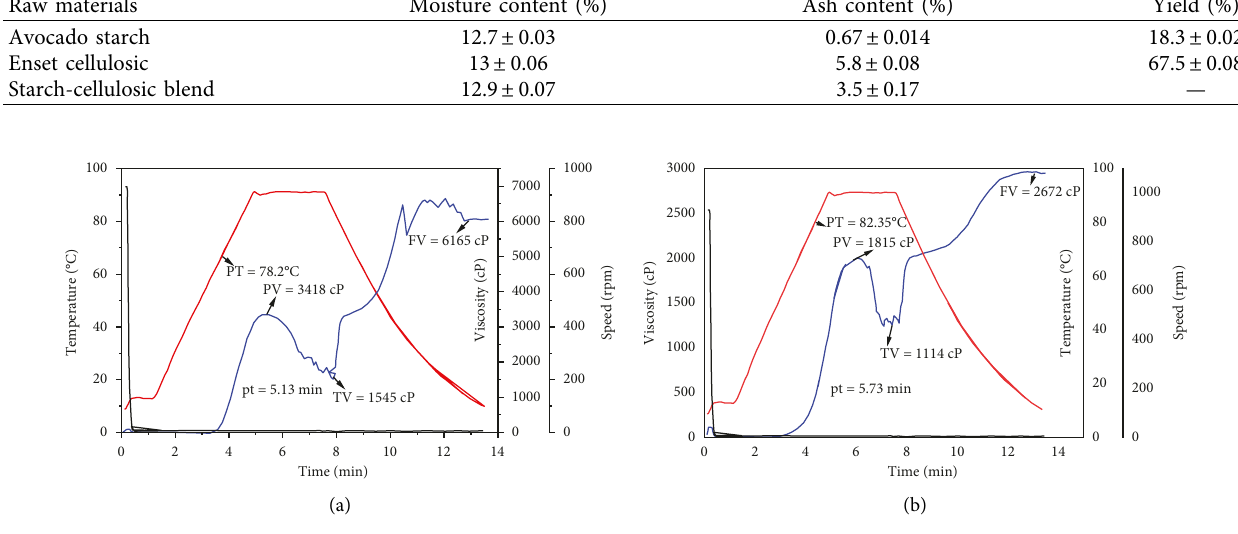
Figure 1: Pasting profile of the (a) starch and (b) starch-cellulosic blend. Table 2: Summary of pasting properties of avocado starch and the